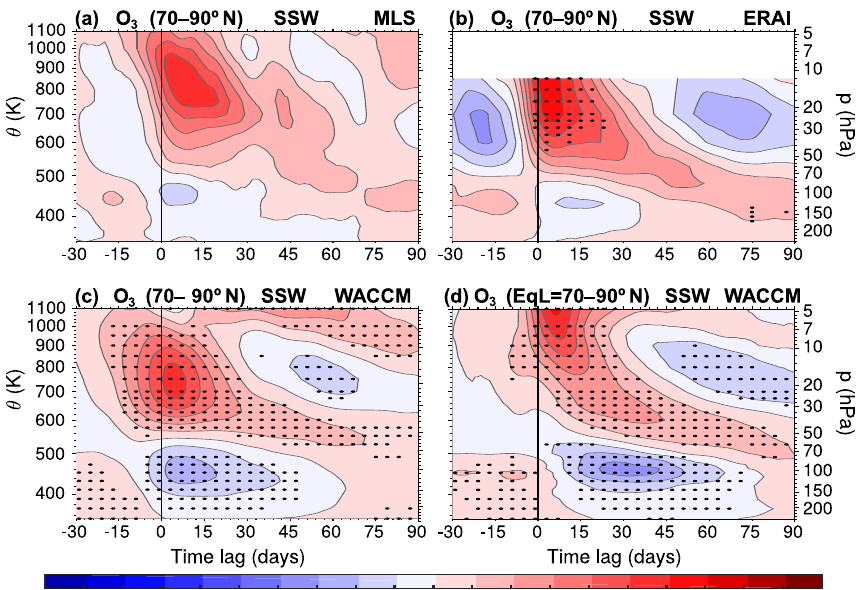
Figure 3. Composite evolution around the SSW central day as a function of potential temperature of ozone concentration anomalies (ppmv) averaged over 70–90 ◦ N for (a) MLS, (b) ERAI, and (c) WACCM; (d) similar composite but averaging over EqL 70–90 ◦ N in WACCM. Black dots denote statistically significant anomalies (two-tailed Student’s t test, α = 0 . 01). Note that the statistical test has not been performed for MLS due to the small sample of SSWs. The approximate pressure level is indicated on the right